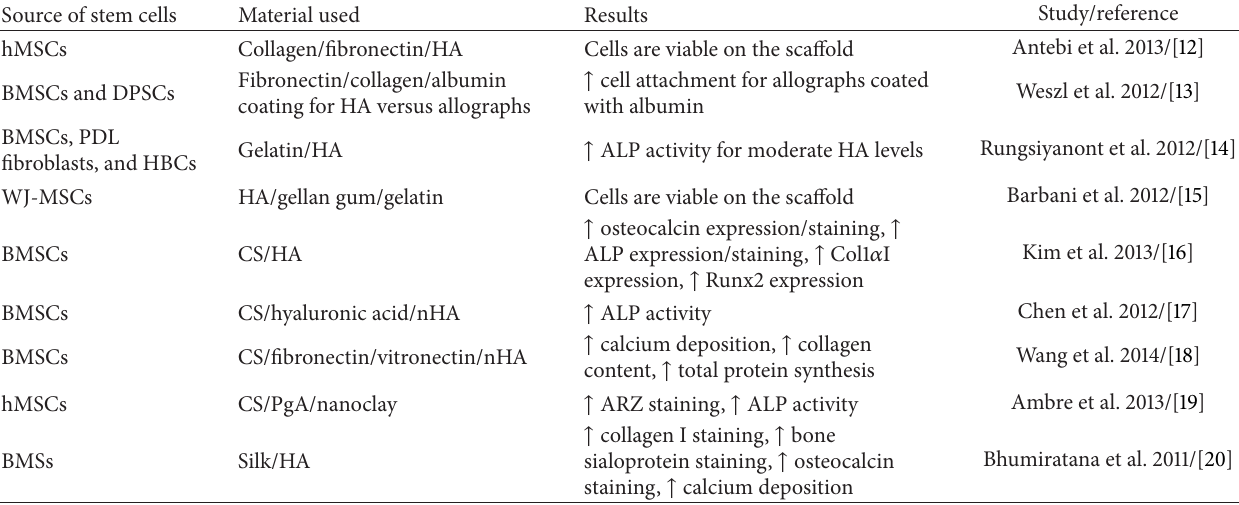
Figure 1: Graphic scheme of the categorization of topics in this review. For the purposes of this review, if materials were more than 50% natural they were considered natural or vice versa. Table 1: Summary of references for natural materials in combination with